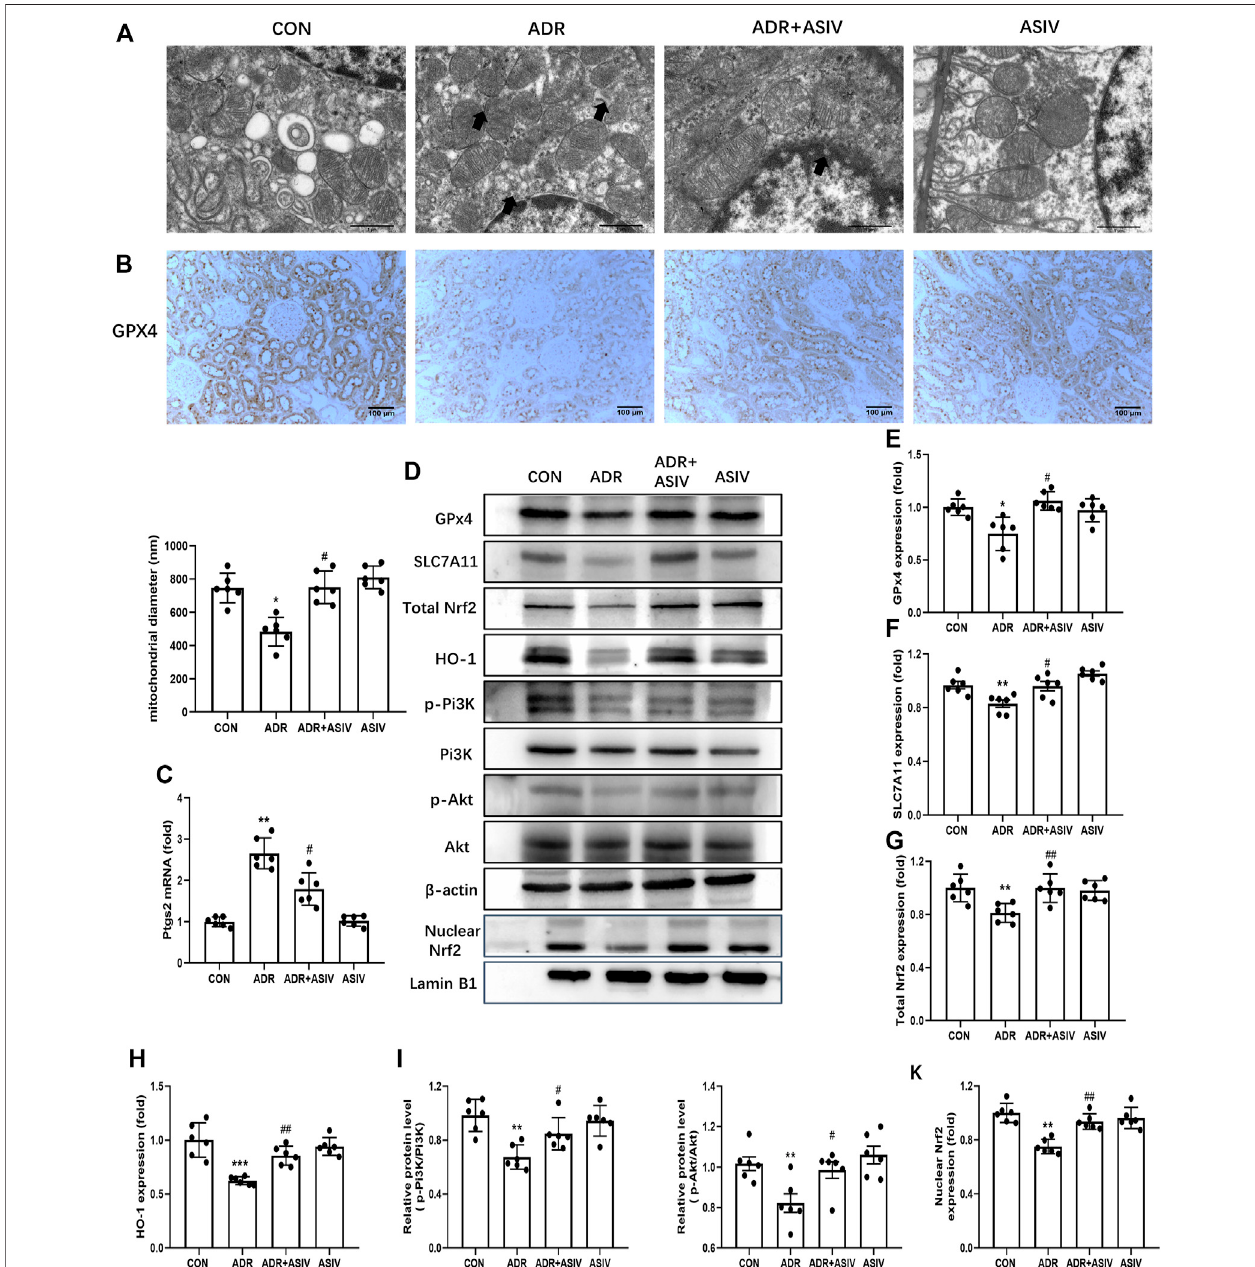
FIGURE 4 | ASIV attenuated ferroptosis-related indicators in the ADR-reduced renal damage. (A) Representative TEM images demonstrating ADR-induced ferroptosis and quanti fi cation of mitochondrial diameters. Black arrows indicated disappeared mitochondrial ridge and outer membrane rupture. (B) Representative GPx4 immunohistochemical images. (C) The Ptgs2 mRNA levels in the renal. (D) Western blot for GPx4, SLC7A11, Nrf2, HO-1, p-Pi3K, and p-Akt in the rat kidney. (E) Quanti fi cation of GSH peroxidase 4 (GPx4). (F) Quanti fi cation of SLC7A11. (G) Quanti fi cation of total Nrf2. (H) Quanti fi cation of HO-1. (I) Quanti fi cation of p-Pi3K. (J) Quanti fi cation of p-Akt. (K) Quanti fi cation of nuclear Nrf2. Data were expressed as mean ± SD, n = 6. * p < 0.05, ** p < 0.01 vs. CON group. # p < 0.05, ## p < 0.01 vs. ADR group.